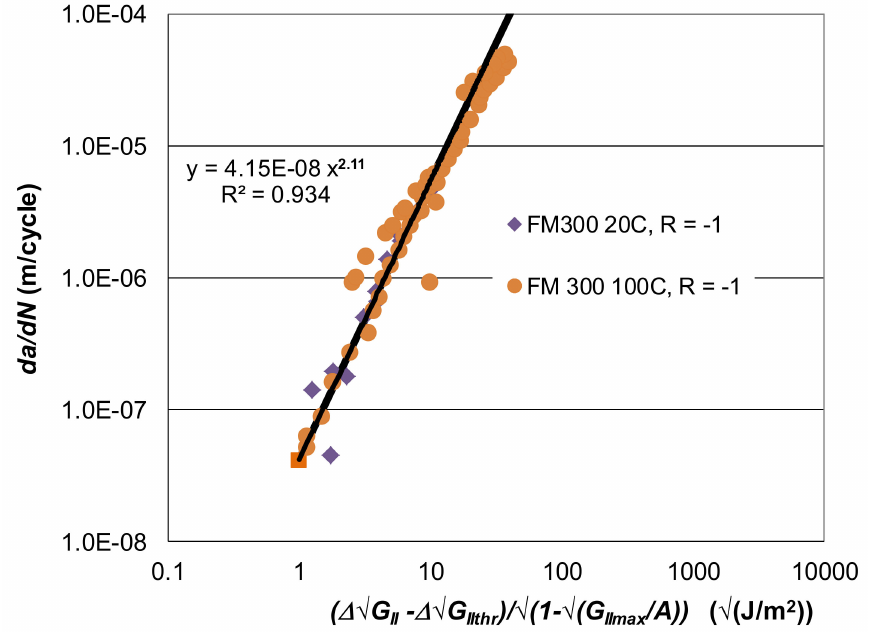
√ G istherangeoftheappliedstrain-energyrelease-rate √ √ √ G = G max − G min ).